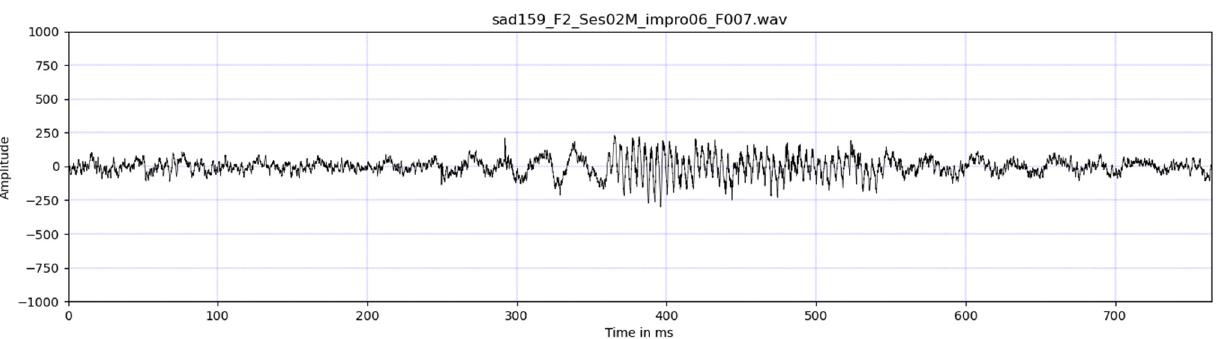
Figure 2. The waveform of a disqualified wav file.